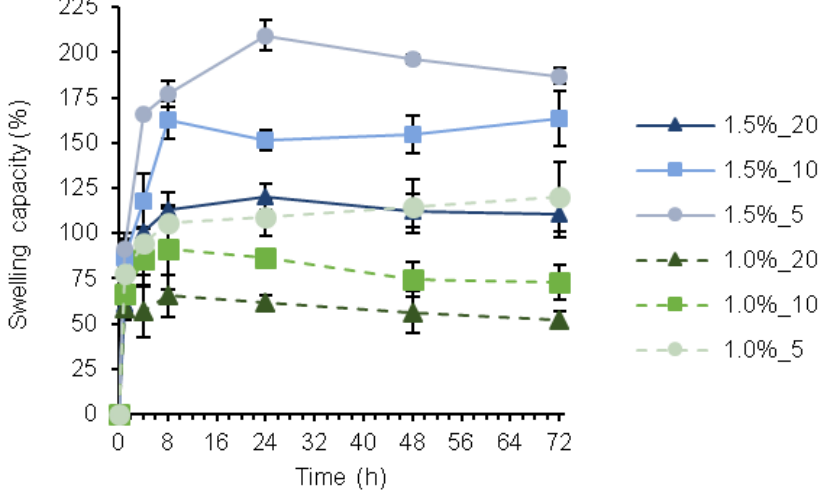
Figure 3. Swelling index (%) of hydrogels prepared with different concentrations of PLN and 1.5% or 1.0% of HA-SH and SF. The results are presented as mean values of swelling capacity (%) (n = 3) ± SD.